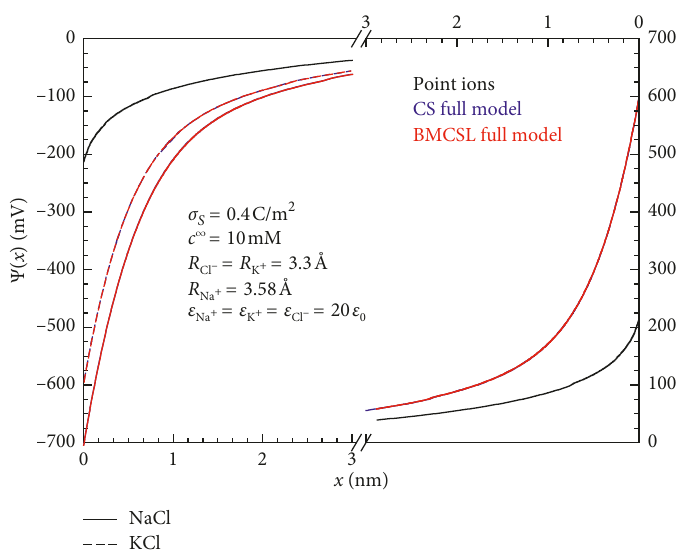
Figure 2: Electric potential profiles in the diffuse electric double layers near negative (left) and positive (right) interfaces, calculated using the CS and BMCSL full models and aqueous NaCl and KCl solutions with the indicated